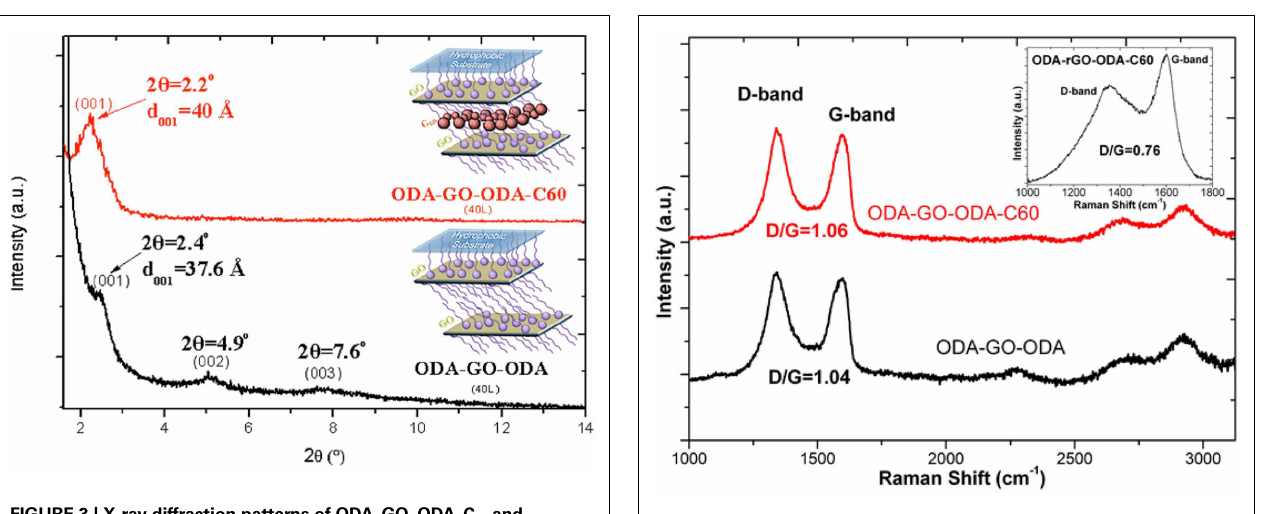
FIGURE 3 | X-ray diffraction patterns of ODA–GO–ODA–C 60 and ODA–GO–ODA hybrid multilayers (40 layers) . FIGURE 4 | Raman spectra of ODA–GO–ODA–C 60 and ODA–GO–ODA hybrid multilayers (40 layers) . Inset: Raman spectrum of